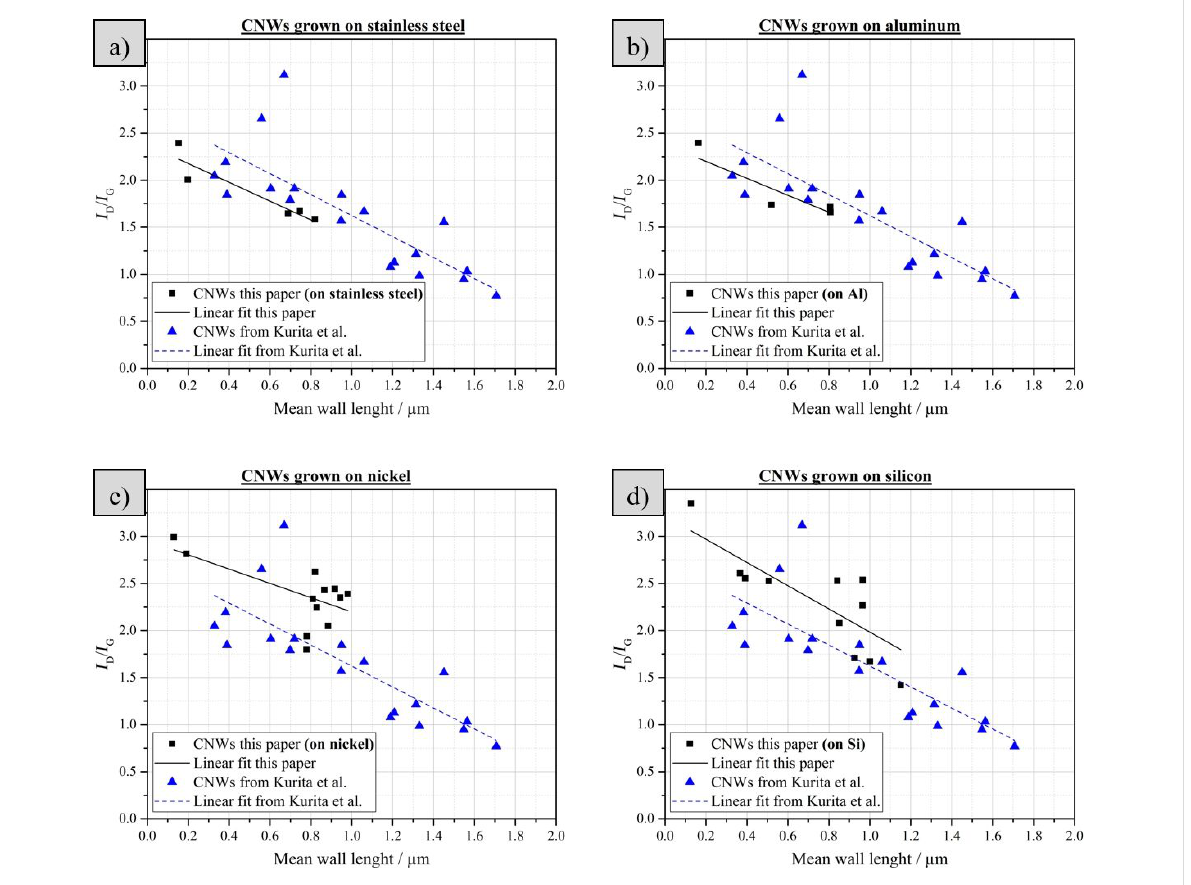
Figure 8: I D / I G ratio as a function of the mean wall length of the straight and the curled CNWs on a) stainless steel, b) aluminium, c) nickel and d) silicon; blue triangles: data points taken from [34].